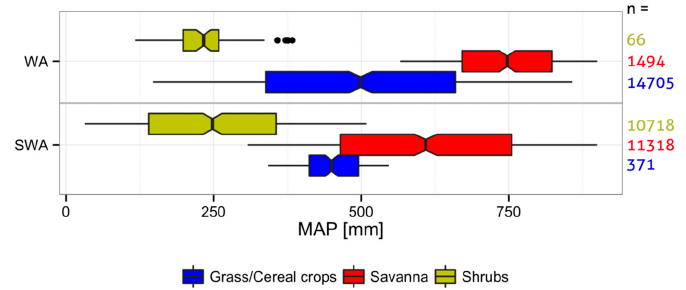
Figure 6. Distribution of the major vegetation types derived from MODIS MCD12C1 Type 3 land